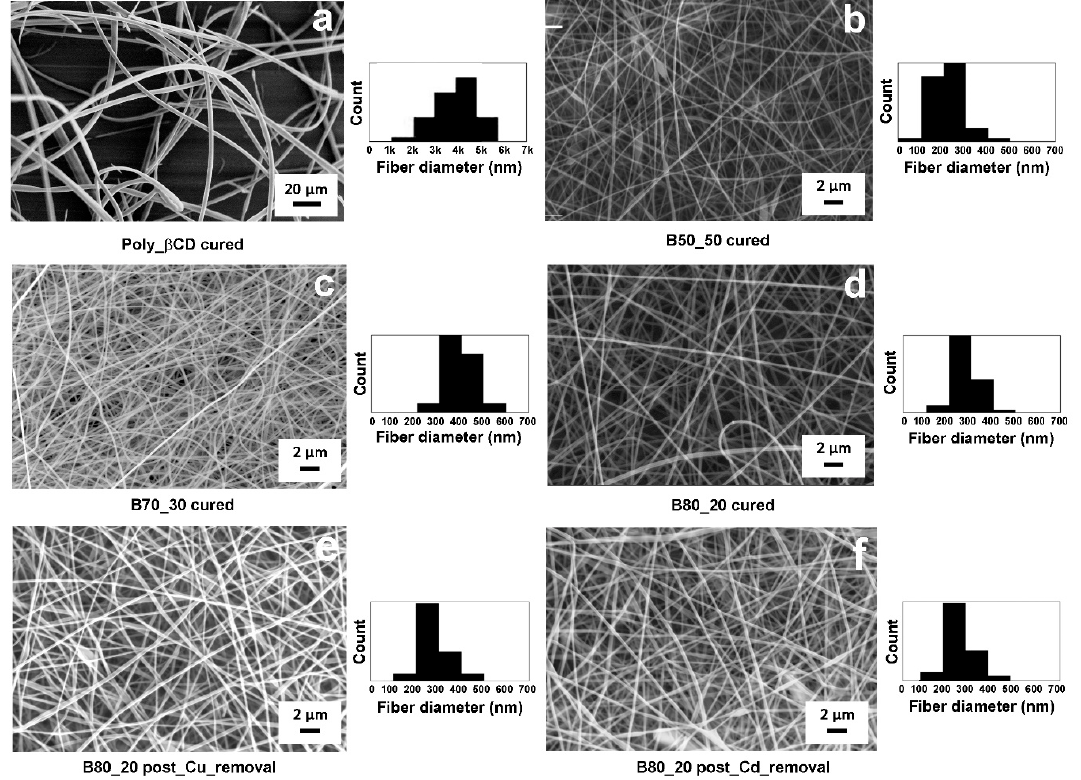
Figure 7. SEM micrographs of cured fibers and histograms showing the fiber diameter distribution: Poly- β CD ( a ), B50_50 ( b ), B70_30 ( c ), B80_20 ( d ), B80_20 after adsorption and desorption of copper ( e ) and cadmium ( f ).